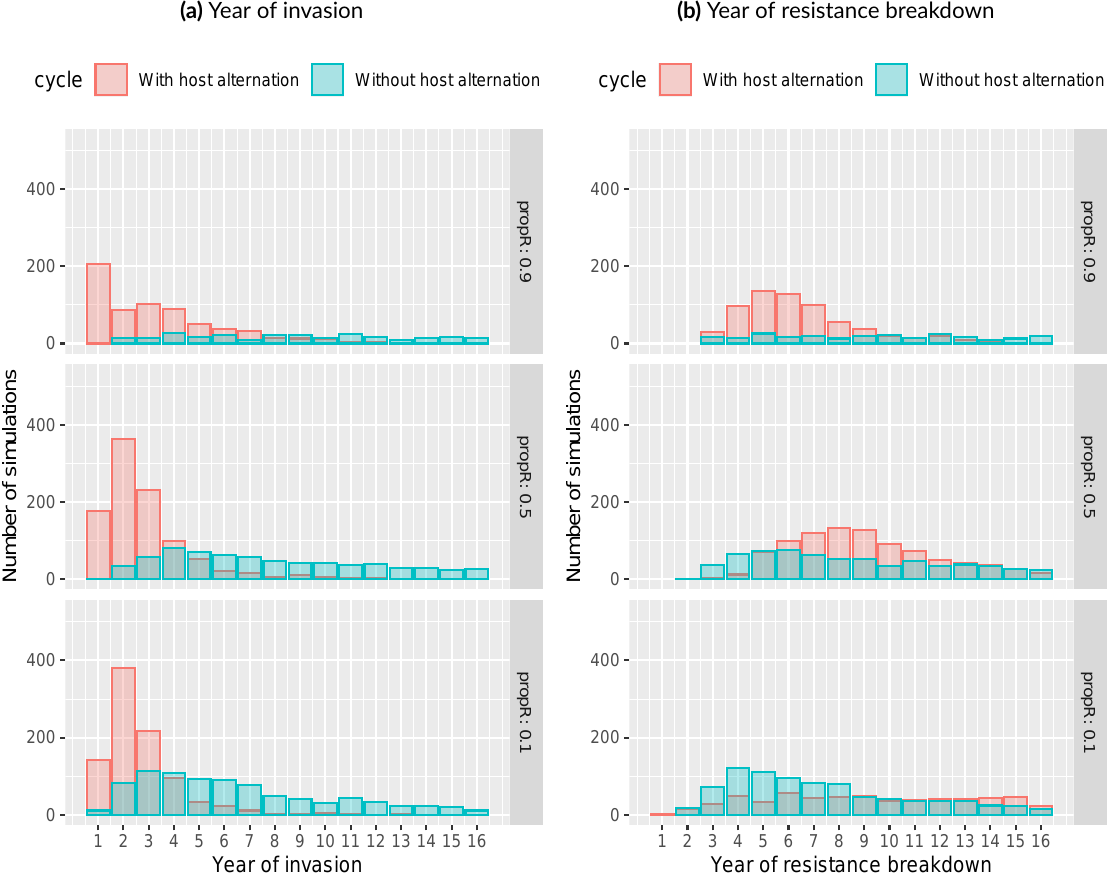
Figure S4 – Histograms of (a) the year of invasion and (b) the year of resistance break- down depending on the life cycle of the diploid pathogen, for three values of propR . Simulations were performed with f avr = 0.02 , mig = 0.001 , and r = 1.5 . The plotted results were obtained from the restricted simulation design, and correspond to all sim- ulations among the 1 000 replicates per combinations for which at least 80% of the R compartment is occupied at the end of the